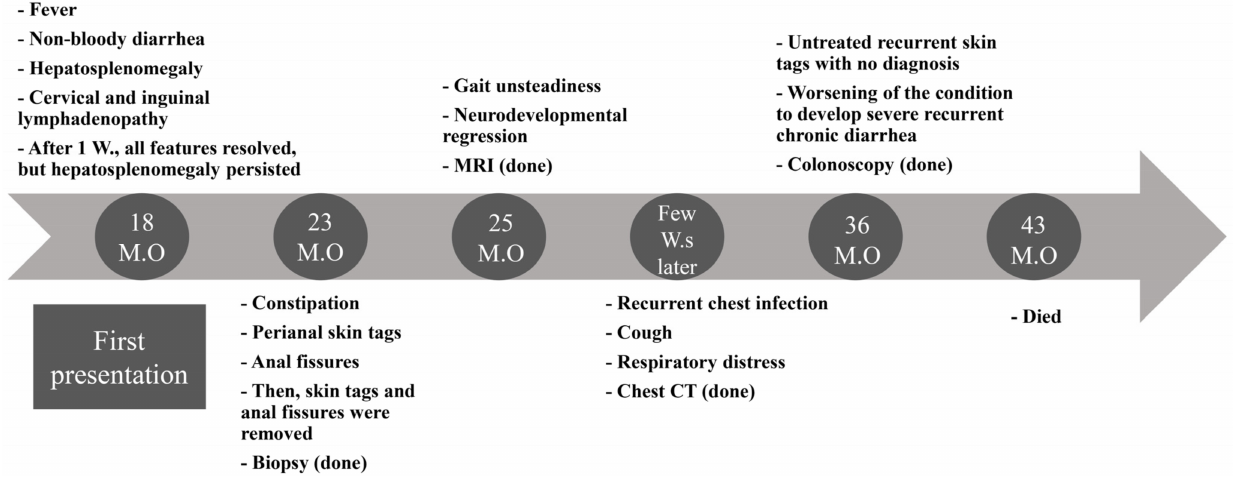
Figure 1. Timeline of the patient’s